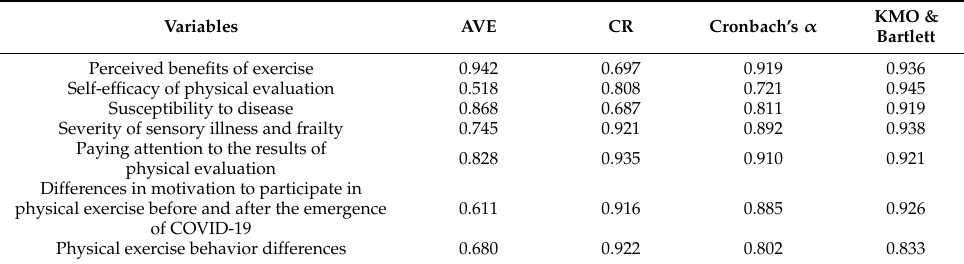
Table 1. The reliability and validity test results for each factor ( n =